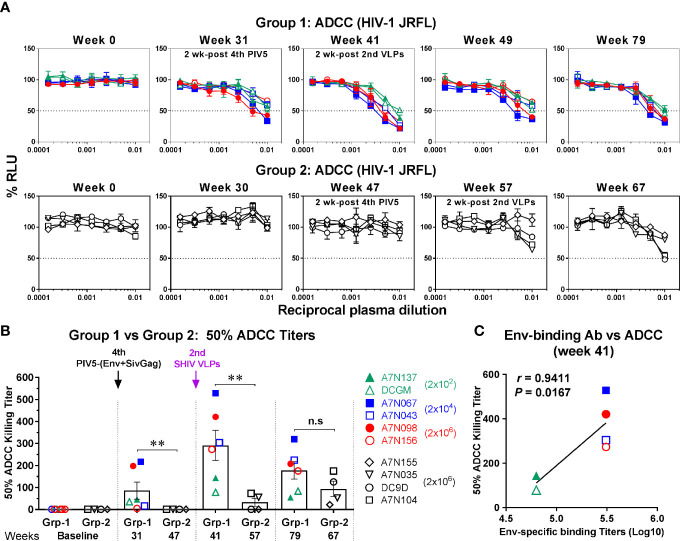
ADCC activity against HIV-1. (A) Plasma samples in Group 1 (upper panel) and Group 2 (lower panel) were tested with CD16-KHYG-1 effector cells to kill CEM.NKR.CCR5.CD4+-Luc target cells infected with HIV-1 JRFL. ADCC activity was measured as the dose-dependent loss of luciferase activity in relative light units (RLU). The dotted line indicates half-maximal infection or 50% ADCC killing (cell lysis) titers. (B) Comparison of 50% ADCC killing titers between Group 1 (Grp-1) and Group 2 (Grp-2) at the indicated time points receiving the same immunization, respectively (solid arrows). Error bars indicate the standard errors of the means. Each dot represents an individual animal. Statistical analyses were considered significant of P values as follows: * P <0.05; ** P <0.01. n.s, P >0.05, not significant. (C) Correlation between Env-specific IgG binding titers and 50% ADCC killing titers in Group 1 (week 41). The correlation coefficients (r) and P values are from Spearman rank analysis.